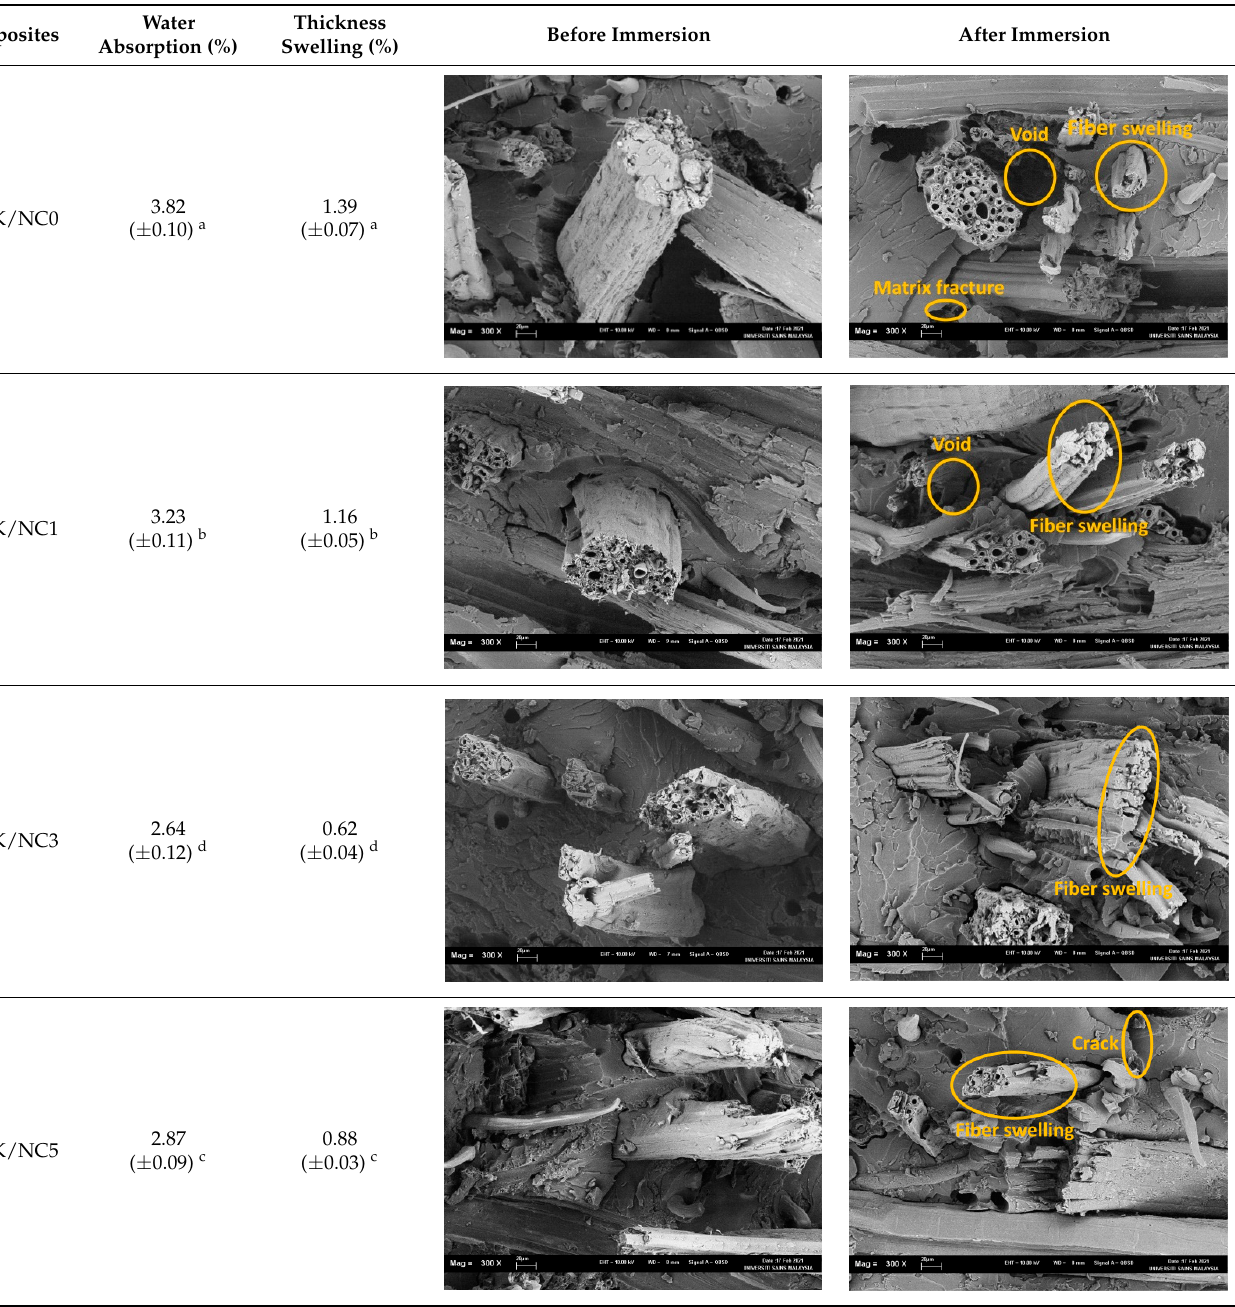
Values are presented as the mean with one standard deviation error bar. The same column followed by different superscript a, b, c, d letters indicates significant differences ( p < 0.05).